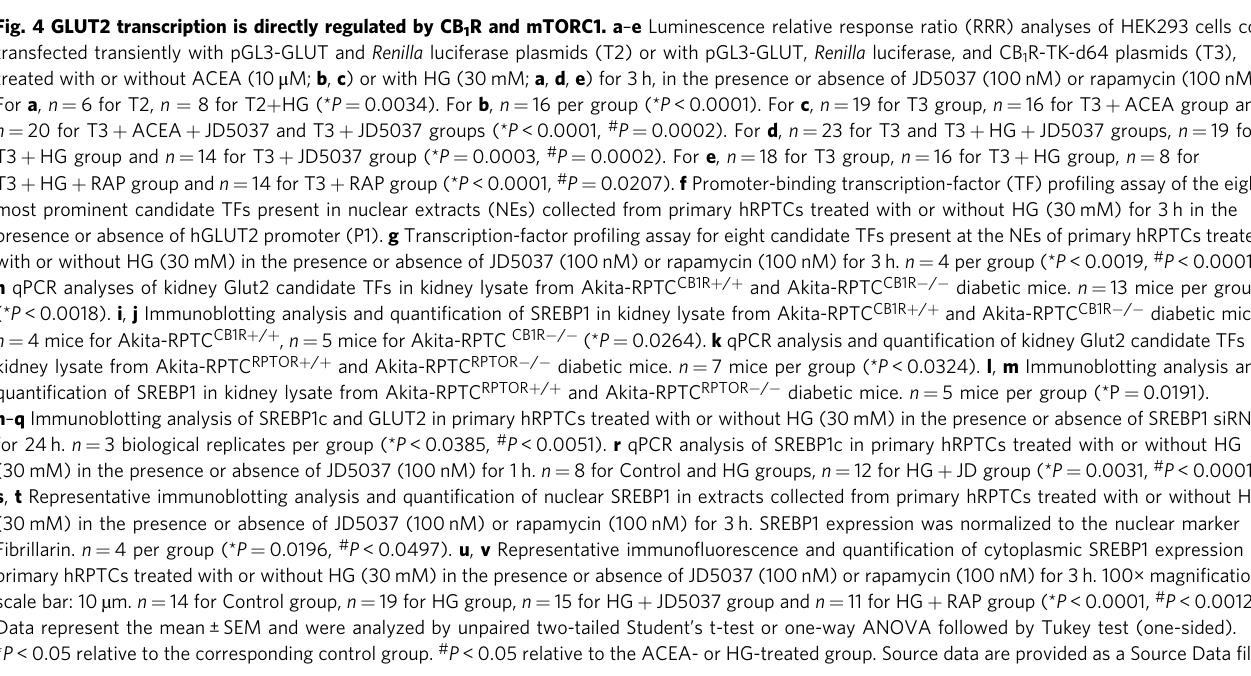
Fig. 4 GLUT2 transcription is directly regulated by CB 1 R and mTORC1. a – e Luminescence relative response ratio (RRR) analyses of HEK293 cells